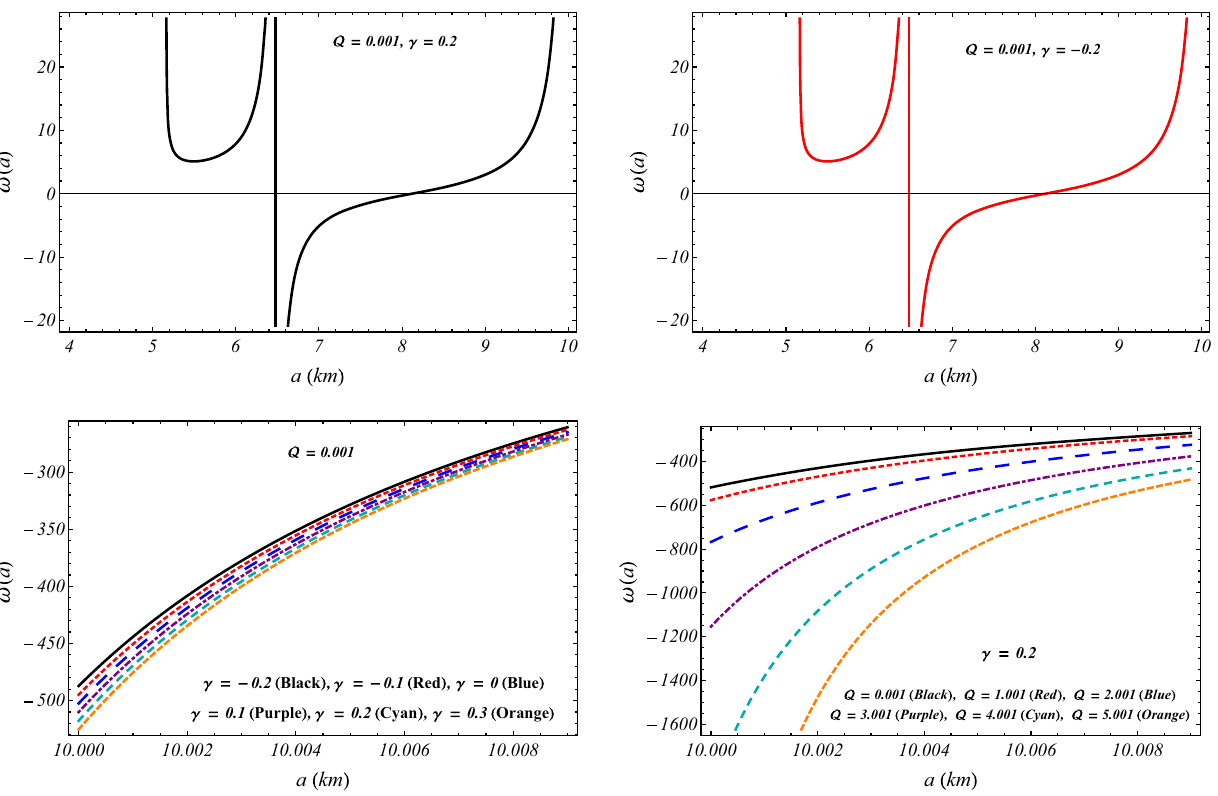
Fig. 6 Top two profiles show the variation of the equation of state parameter in the interior region, bottom two panels show the variation of equation of state parameter inside the thin